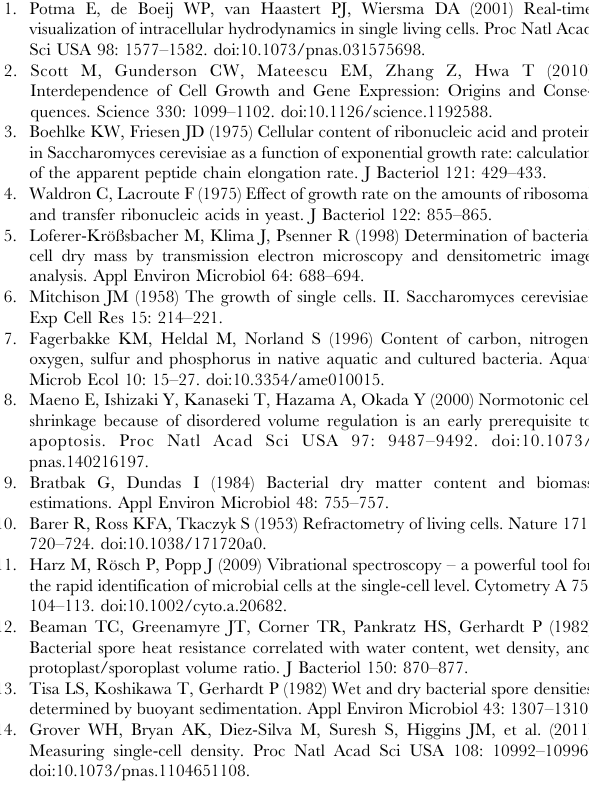
Figure S8 Time between measurements (exposure time) versus calculated dry density for single S. cerevisiae cells in four experiments. Line shows ordinary least squares fits, which never account for more than 5% of the total variance. Because these experiments were done three-channel devices, much more precise control over exposure time could be achieved, and this parameter was deliberately varied, yielding the discrete times seen above. Only one experiment showed a statistically significant correlation ( a =0.05/4 = 0.0125 using Bonferroni correction). P-values are given for slope being non-zero using one-sided t-test. (TIF) File S1 Supplemental discussion: error sources, evidence for complete fluid exchange, description of water-content measure-